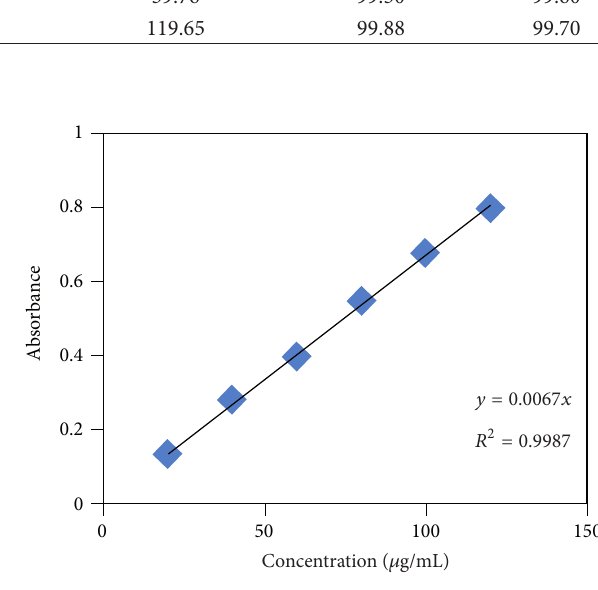
F 3: Calibration curve of ART. F 4: Calibration curve of